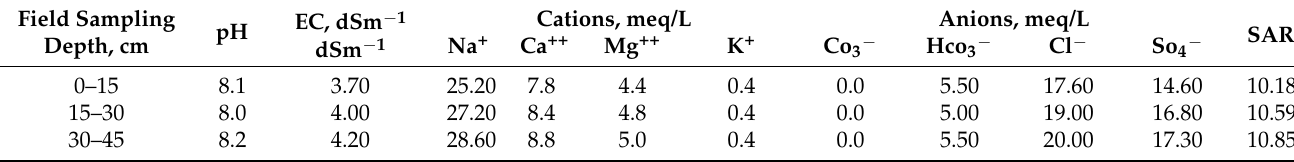
Table 2. Some chemical properties of the experimental